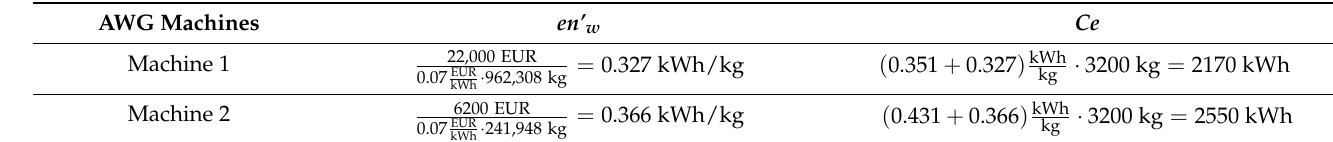
Table 4. Calculation of en’ w and Ce